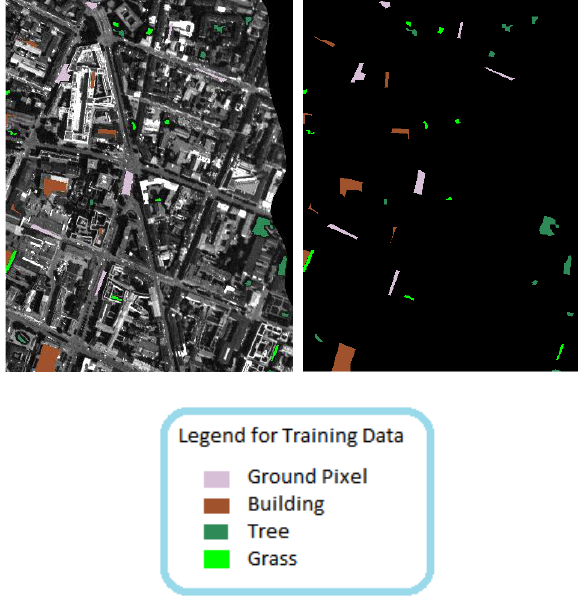
Figure 5. SVM classification method on the hyperspectral